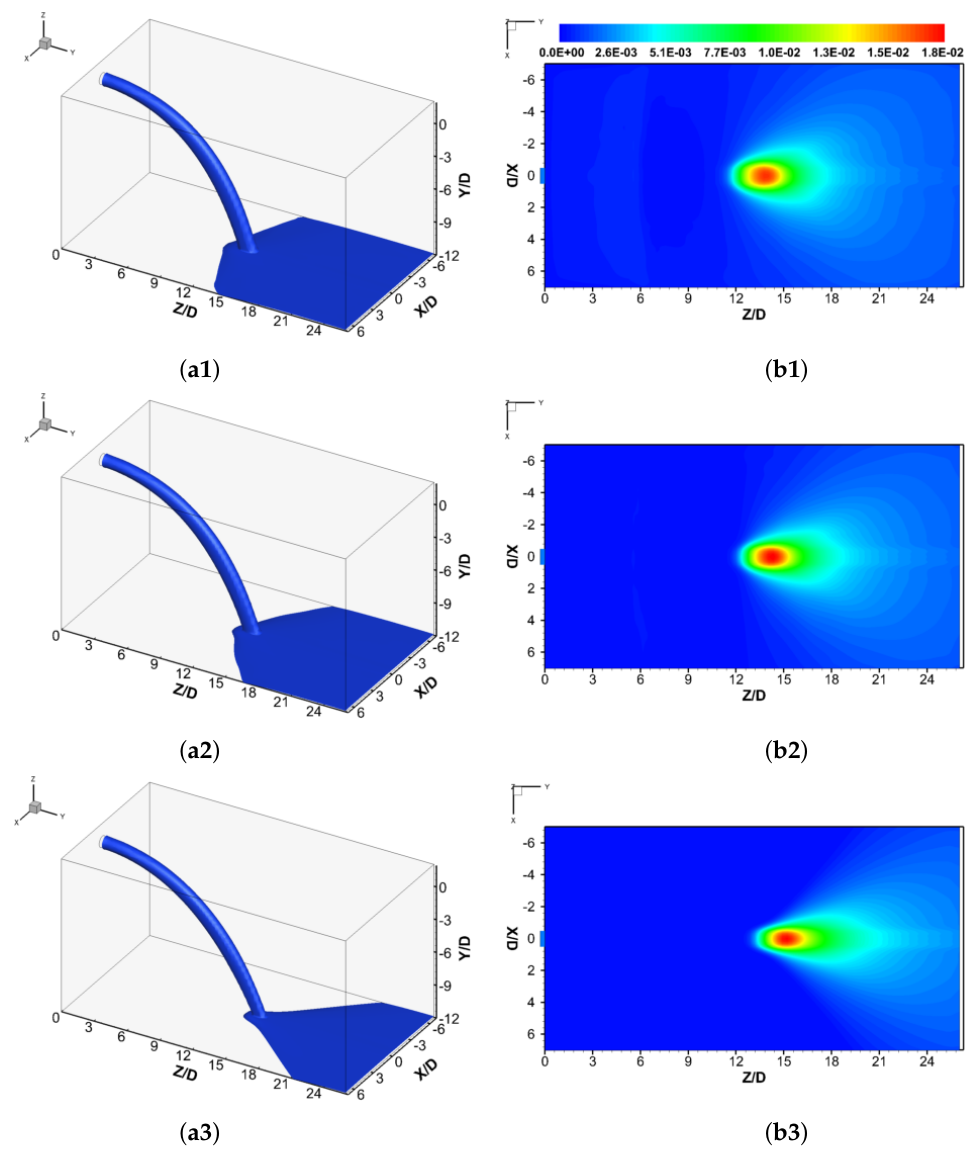
Figure 6. 3D view of the iso-surface contours of solid volume fraction for Case-1 to Case-3 ( a1 – a3 ) and 2D view of contours of solid volume fraction on the ground wall for Case-1 to Case-3 ( b1 – b3